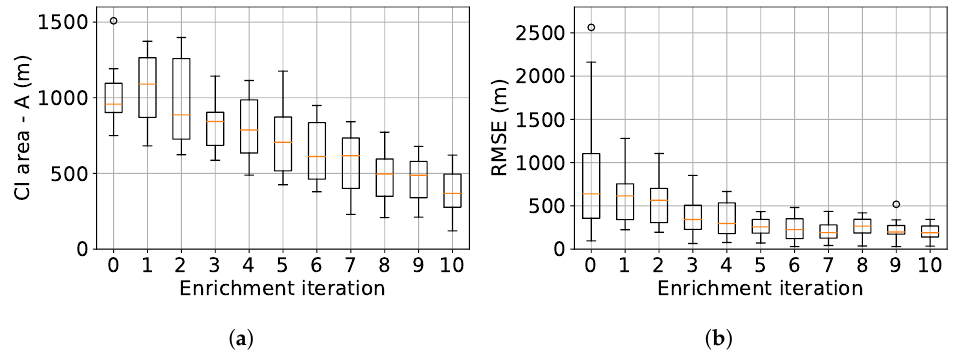
Figure 19. Estimation of the quantile confidence area ( a ) and root mean square error ( b ) along the 10 active-learning iterations for 10